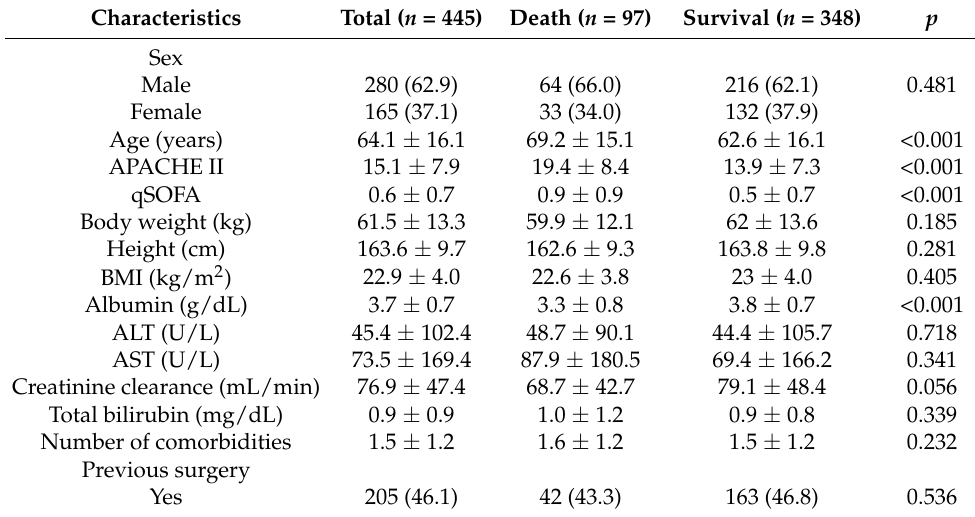
Table 1. Association of patient characteristics with hospital